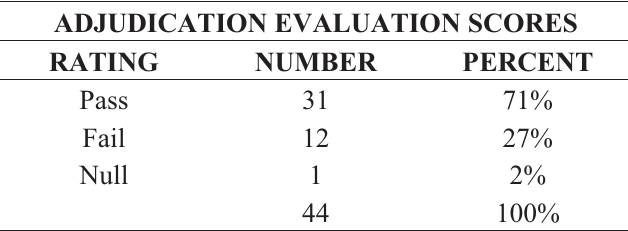
Table 3. Adjudication Evaluation